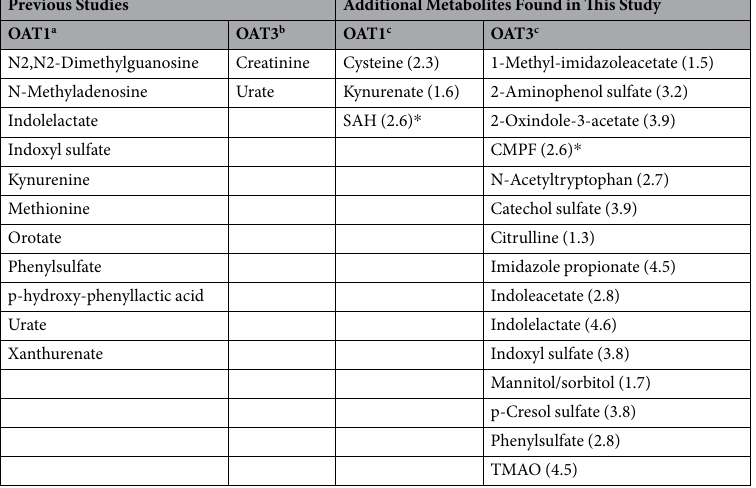
Table 1. Uremic toxins/retention solutes with significantly altered concentrations in Oat1 and Oat3 knockout mice based on previous and current metabolomics studies. a OAT1 references for previous studies: PMID:16354673; PMID:2146605). b OAT3 references for prior studies (PMID:18270321; PMID:18508962; PMID:2238083; PMID:2390220). c The number in parentheses is the fold increase in plasma concentration for the listed metabolite. * p ≤ 0.05 for all fold increases except those for SAH and CMPF (p <